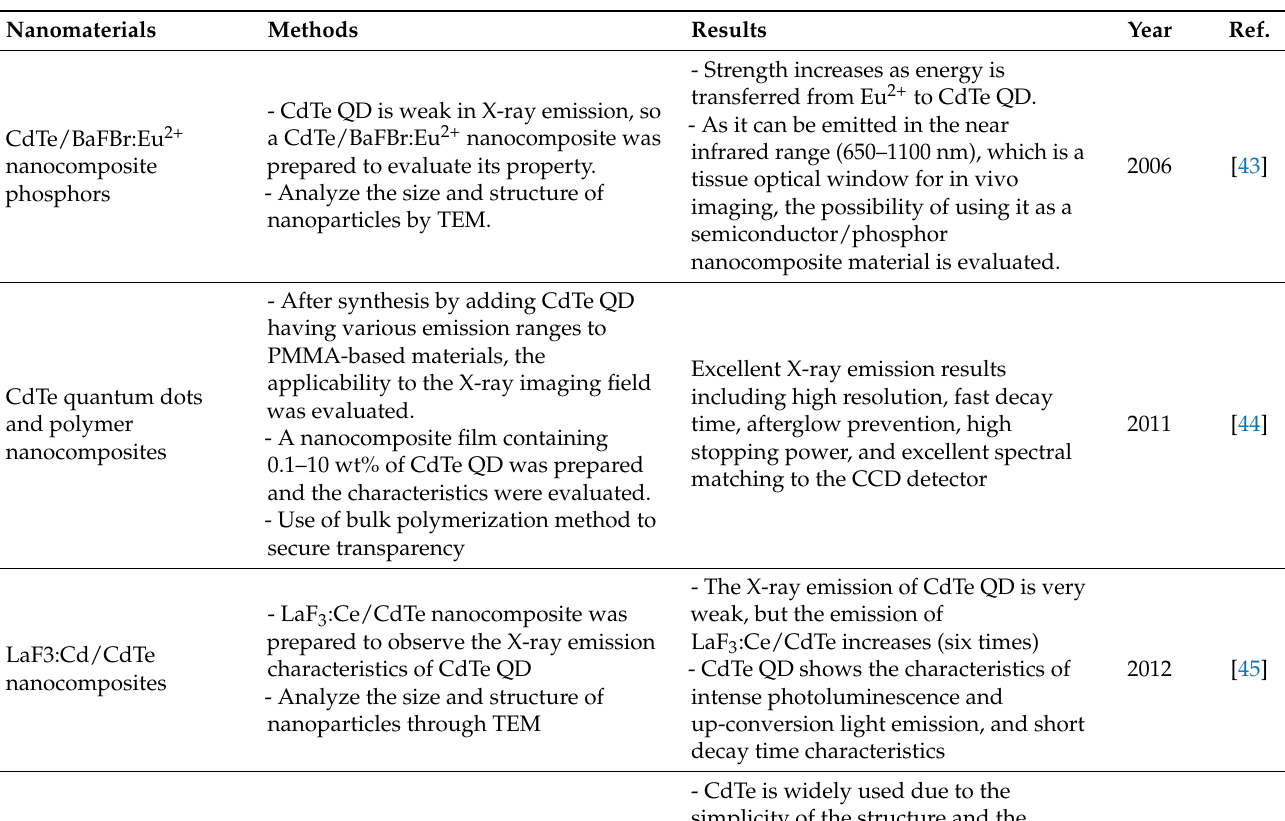
Table 4. Progress of CdTe-enabled optical